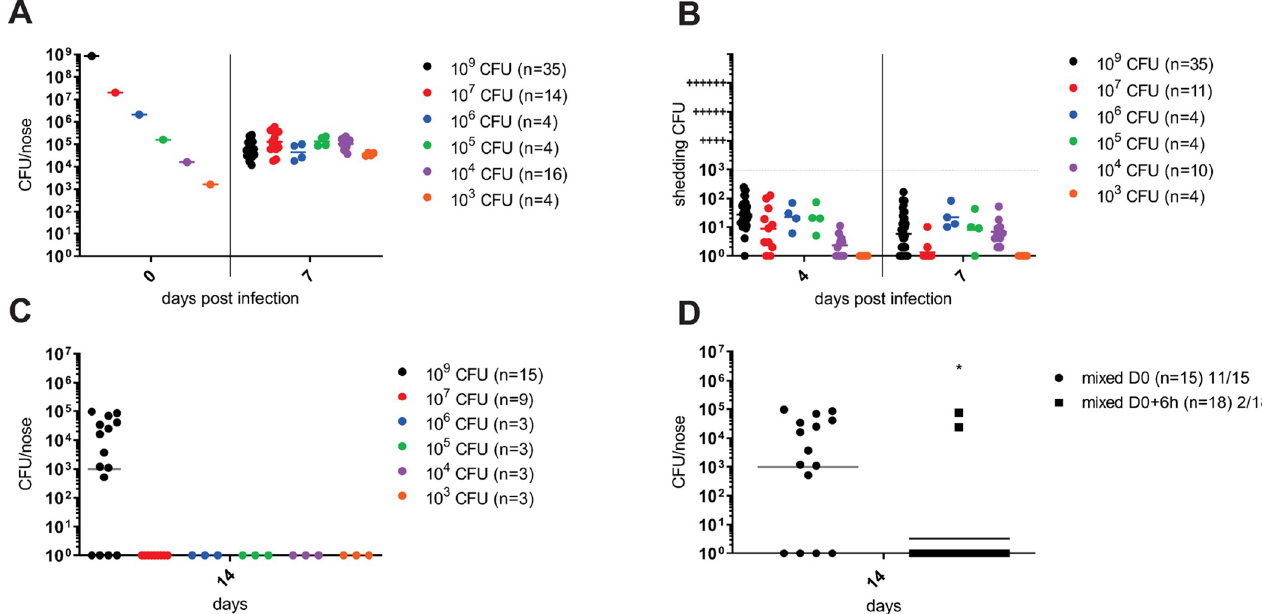
Fig 2. High bacterial inoculation enables low level nasal shedding and occasional transmission of B . pertussis between adult C57BL/6J mice. ( A ) Nares of C57BL/6J mice were inoculated with 5 μ l of bacterial suspensions containing from 10 3 to 10 9 CFU of B . pertussis cells and bacterial loads in infected nasal cavities were determined on day 7 by plating of nose homogenates. ( B ) Prior to euthanasia, B . pertussis shedding from the nasal cavities of infected mice was quantified on days 4 and 7 by gentle tapping of the mouse noses on the surface of a BG agar plate containing streptomycin (100 μ g/ml) and spreading of the deposited bacteria in 100 μ l PBS over the plate surface for CFU determination. ( C ) Index mice inoculated into nares with the indicated dose of B . pertussis CFUs were immediately co-housed in the same cage in a 1:1 ratio with non-inoculated recipient mice for 7 days before the index mice were withdrawn for determination of nasal shedding and euthanized for determination of bacterial loads in their nasal cavities. The co-housed recipient mice were kept for another week prior to determining the bacterial loads in their nasal cavities on day 14. ( D ) In parallel, further index mice inoculated with the highest dose of 10 9 CFU of B . pertussis were kept in separate cages for 6 hours before being brought in contact and co-housed in a 1:1 ratio over 7 days with the non-infected recipient mice and nasal shedding, nose colonization level and transmission to recipient mice was analyzed as above. Statistical significance of CFU count difference of transmission between the immediately co-housed mice and mice co-housed with 6 hours of delay was assessed by unpaired t-test. � (p < 0.05). Each dot represents bacterial counts for an individual mouse. Horizontal bars indicate the geometric means. The data for nasal colonization (A) and shedding (B) of the index mice inoculated with 10 9 CFU were pooled for the 35 mice used in seven independent experiments (n = 35). The number of mice used for each infection dose is given in brackets.